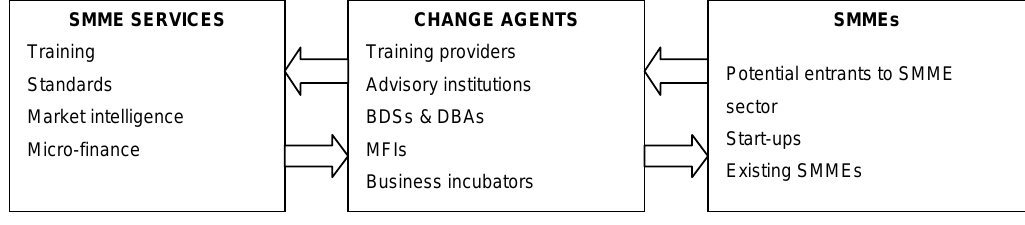
Figure 1: Functional model for strategic implementation in the SMME sector